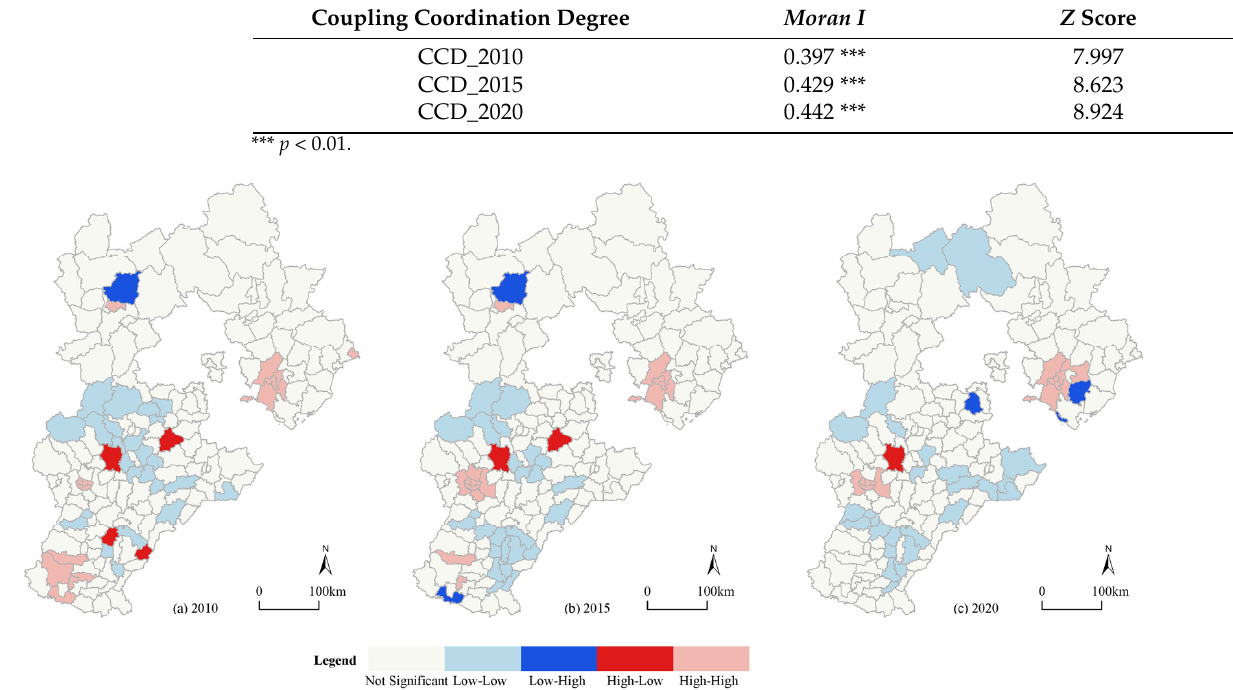
Table 7. LM, LR test and Hausman of the spatial models with W1 and W2.